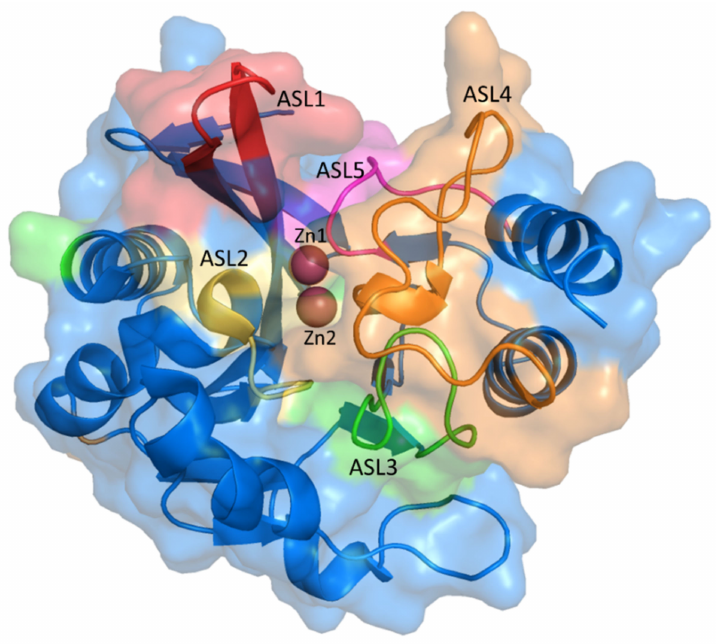
Figure 1. The 3D structure of NDM-1 (PDB ID: 5ZJ2) with the active site loops